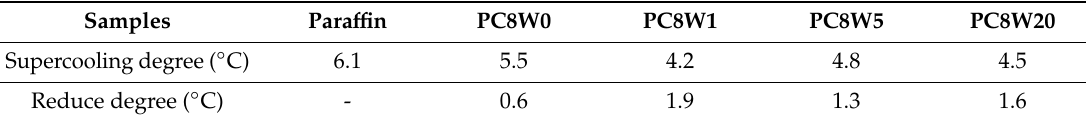
Table 4. Subcooling degree of AGA / para ffi n composite